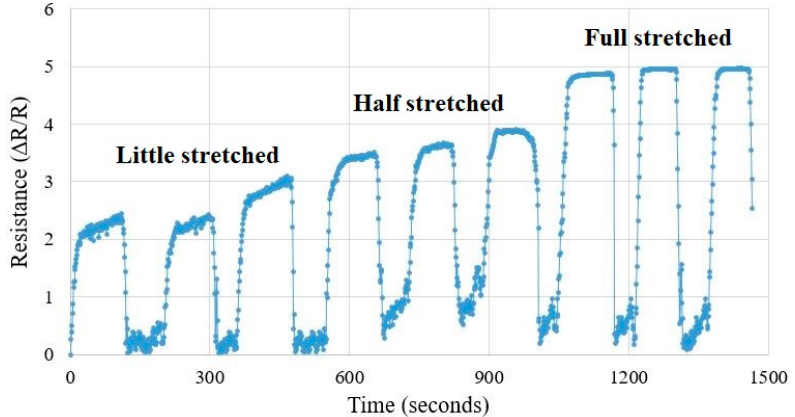
Figure 13. The response of the sensor patches with respect to the variation of tensile strain applied to them. The stretching of the sensors was varied from little stretched to full stretched condition to determine the increase in the corresponding resistance values.